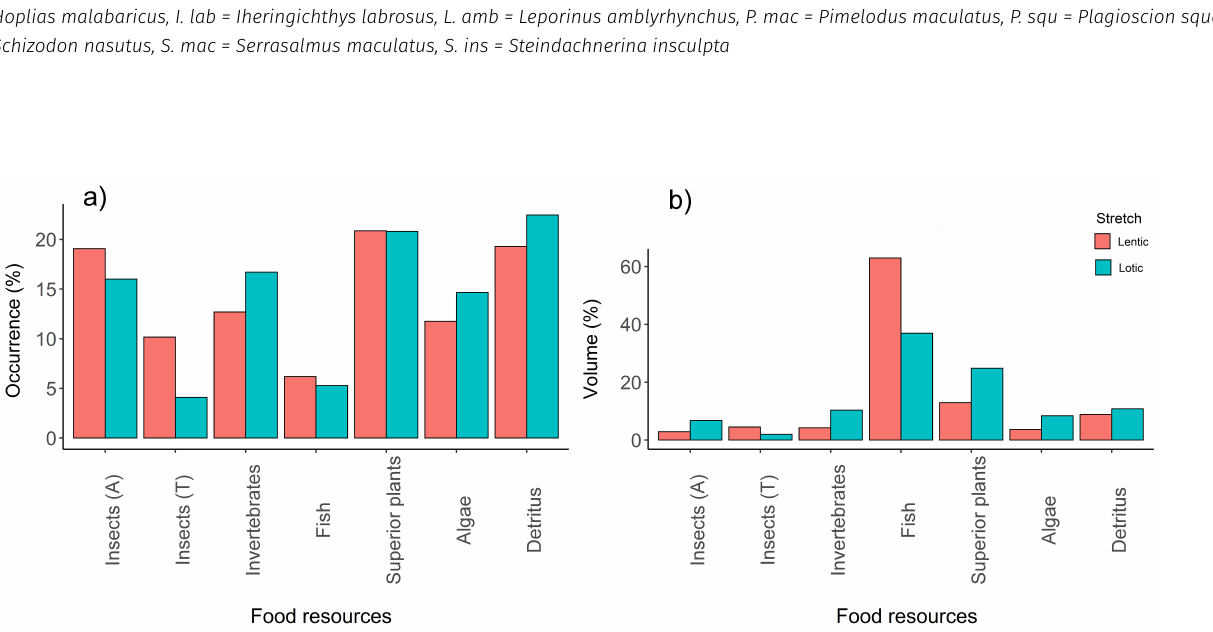
Figure 2. Percentage of a) frequency of occurrence and b) volume of trophic categories in the lentic and lotic stretch of the Chavantes Reservoir, middle Paranapanema river